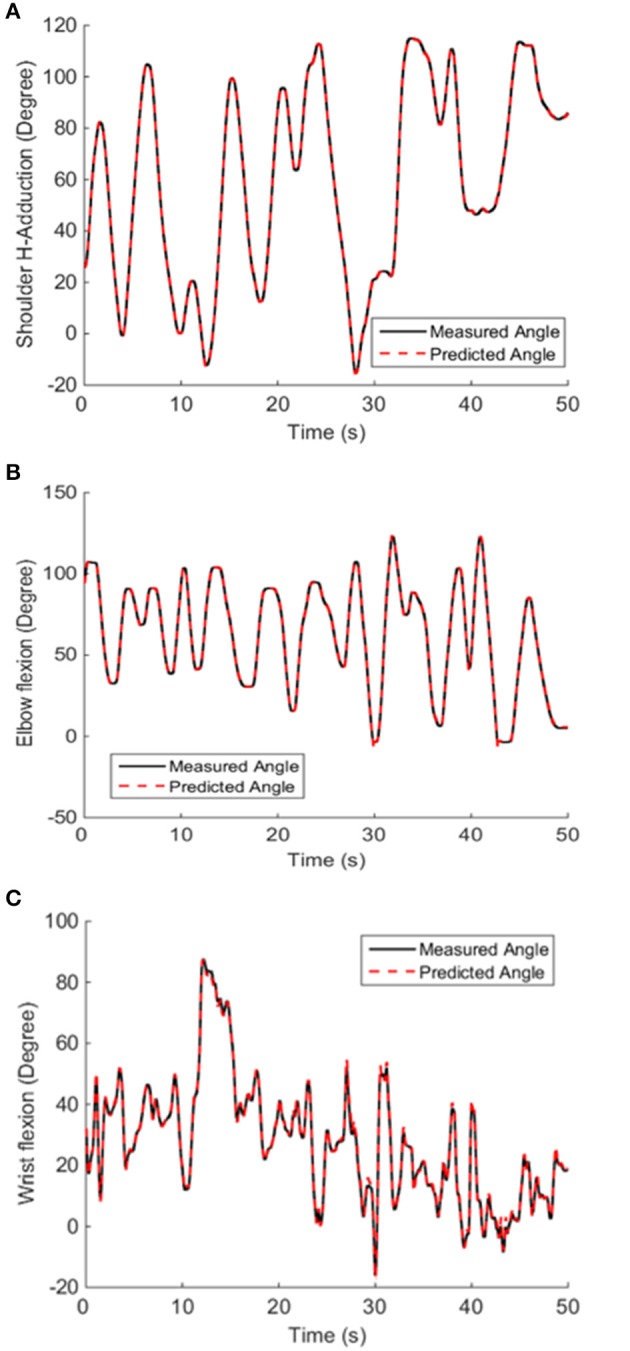
Decoded and measured shoulder (A), elbow (B), and wrist (C) joint angles from a representative subject. The NARX neural network accurately predicted actual kinematics with the prediction interval of 100 ms. The VAF of the predicted shoulder, elbow and wrist position calculated from fresh validation data (50 s long) were 0.9999, 0.999, and 0.9977, respectively.